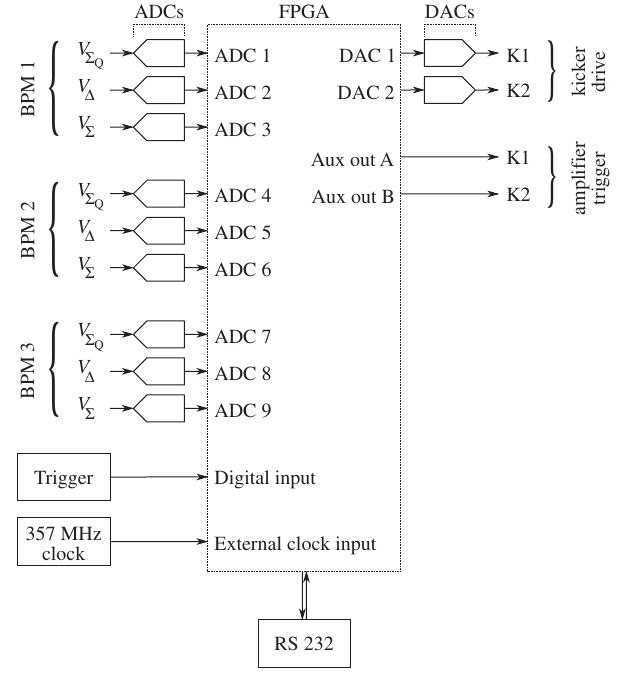
FIG. 10. Schematic of the FONT5A digital feedback